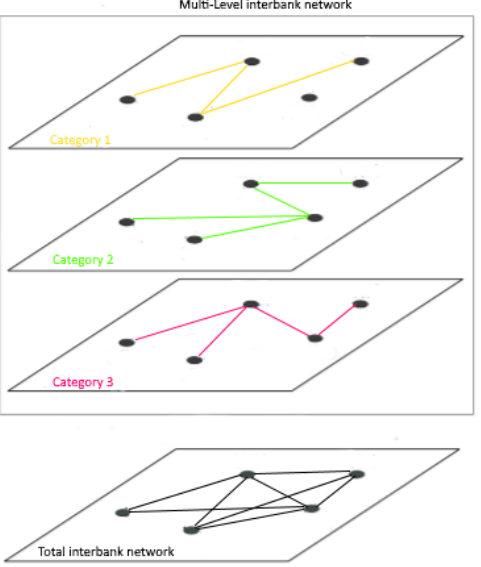
Figure 2. Schematic representations of multilevel interbank networks. Each node is a bank, and links represent credit relations. The network in black is the total interbank market, obtained by aggregating all